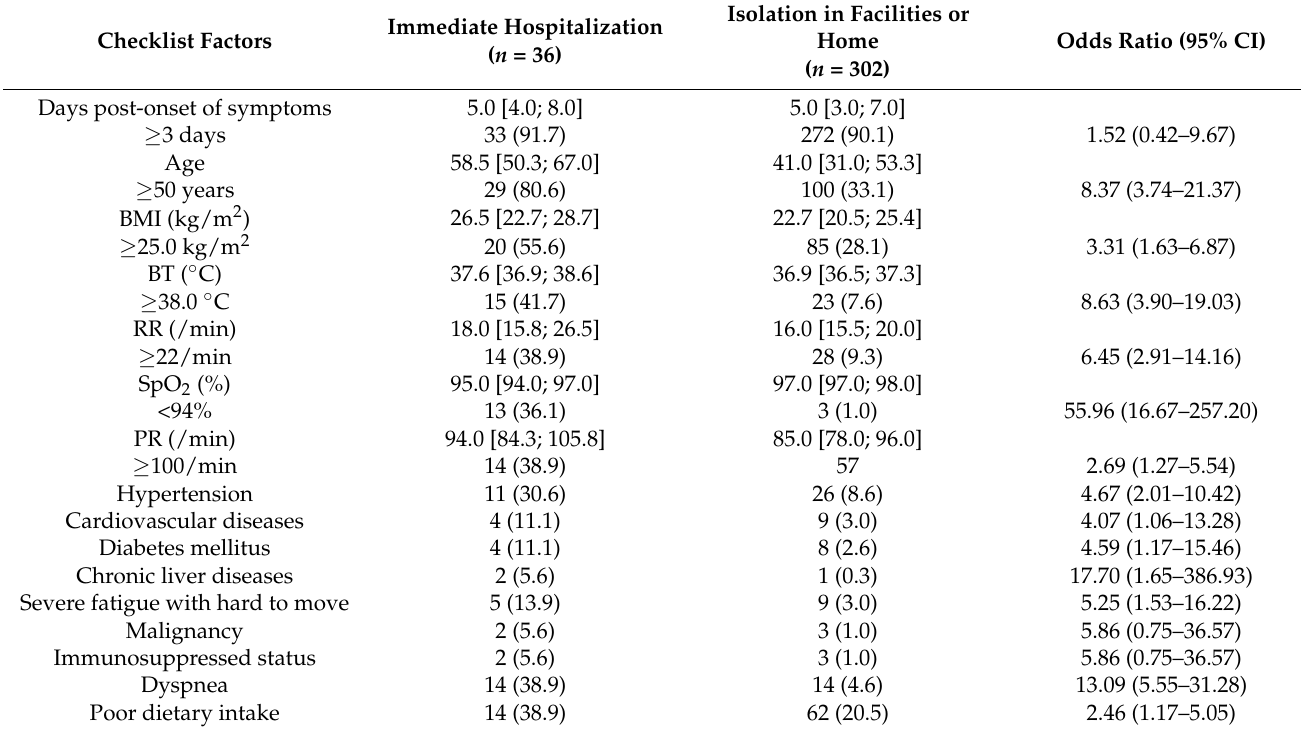
Table 2. Checklist factors and immediate hospitalization at outpatient triage.